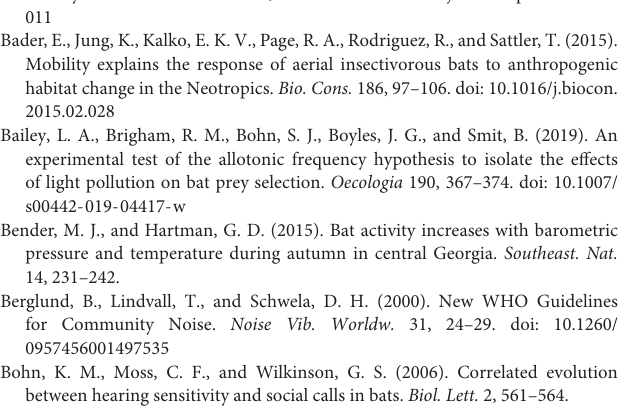
Supplementary Figure 1 | AI across the transect for the two main foraging guilds, open-air foragers (right bar) and clutter-edge foragers (left bar), and for two different behaviours, foraging (lower bars) and commuting (upper bars). The activity index of the clutter foragers and social activity were excluded from the current plot as clutter forager activity social calls were minute in comparison to the other two foraging guilds and activity types (see Table 1 for